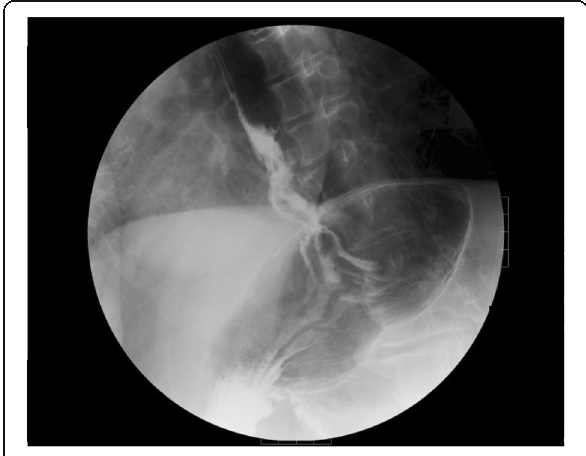
Fig. 2 Upper gastrointestinal (GI) fluoroscopy showed a transdiaphragmatic, circular ulcerative tumor that measured 7cm along its major axis within the esophageal